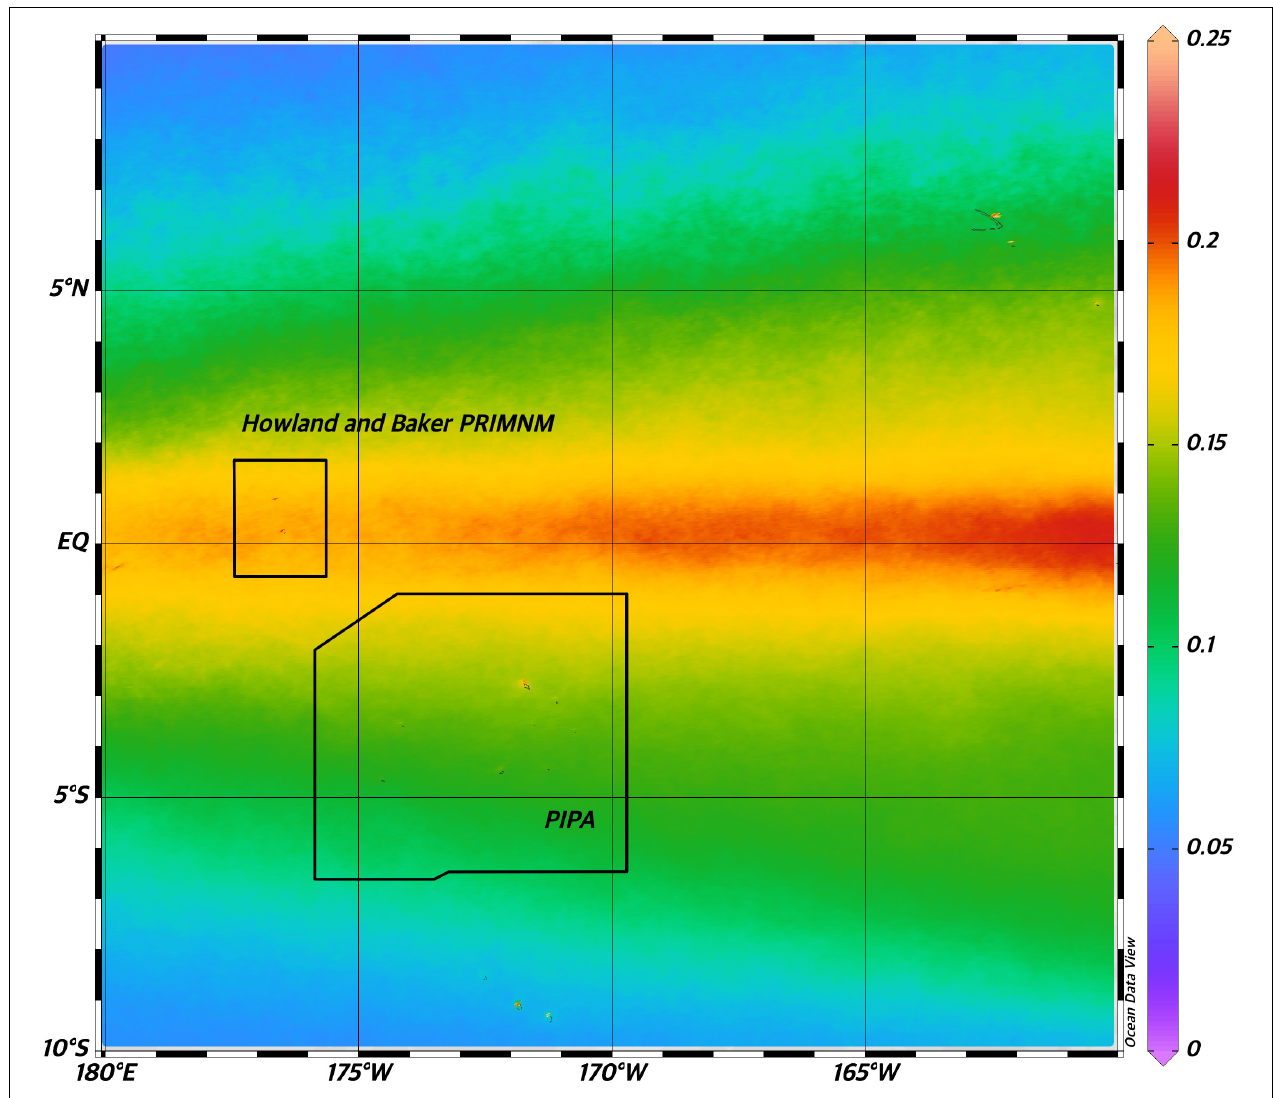
FIGURE 5 | Mean surface chlorophyll concentrations [ µ g*l − 1 ] from MODIS Aqua satellite mission from 2002 to 2020 showing the spatial overlap between the equatorial upwelling region and both PIPA and Howland and Baker PRIMNM unit (NASA). NASA Goddard Space Flight Center, Ocean Ecology Laboratory,